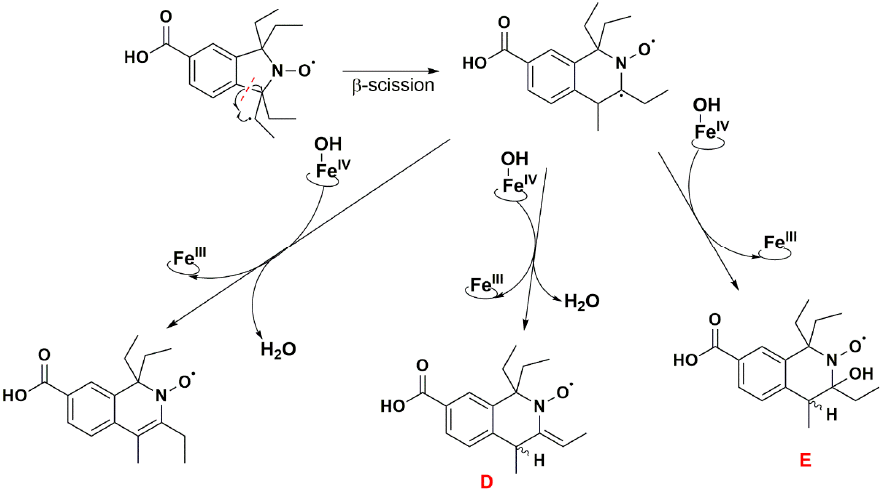
Figure 10. Proposed reaction pathway in the aerobic transformation of nitroxide 5 by RLM and NADPH, part III. Explicit hydrogens attached to carbon atoms in structures D and E correspond to potential origin of the coupling seen in the EPR spectra. The given RT values correspond to the reconstructed chromatograms of the principal ions obtained in HRMS study and were characterized by a delay of 0.2 min compared to the UV-Vis detection (see Figure 7). Structures A , B , C , D and E (Figures 8–10) are potential candidates for the new para- magnetic species, which is transient and contains a hydrogen atom in close vicinity of the unpaired electron, leading to an extra splitting in the EPR spectra. DFT calculations were performed to confirm which β -scission reaction pathway was the more favorable and to identify the structure of the paramagnetic intermediate. First and foremost, the structure of nitroxide 5 was subjected to geometry optimization using the B3LYP/G functional and used to benchmark the DFT results with respect to the nitrogen hfcc. Solvent effects were induced using the CPCMC approach with water as a solvent. Different basis sets were tested and the 6–31 g* provided the fairest agreement between experiment and theory (Supplementary Table S4). However, as the computed nitrogen hfcc (37.2 MHz/1.33 mT) was underestimated when compared to the experimental value (43.4 MHz/1.55 mT), we attempted to improve our predictions by considering new DFT models including one, two and three explicit water molecules in the surrounding of the N-O group in nitroxide 5 (Supplementary Figure S8), following a methodology similar to that used in our previous study [41]. We verified that the corresponding structures converged to a real minimum by performing numerical frequency calculations. Calculations were found converged when one single water molecule was considered and the inclusion of additional solvent molecules did not further improve the predictions (Supplementary Table S5). A value of 41.6 MHz/1.49 mT was obtained for the computed hfcc of nitroxide 5 model with one ex- plicit water molecule, in good agreement with the experiment. Furthermore, given that at 𝑝𝐻 7.4 nitroxide 5 was deprotonated, we optimized the geometry of nitroxide 5 in car- boxylate form with one explicit water molecule in the surroundings of the NO group and consistent EPR parameters were computed (A N = 42.1 MHz/1.50 mT). Based on these re- sults, we pursued our investigations considering the possible compounds A to E interact- ing with a single explicit water molecule. For species A , B , D and E, we obtained computed hfccs that did not agree with the experimental ones (Supplementary Table S6). Structure C may exist as trans and cis isomers when considering the position of the explicit hydrogen